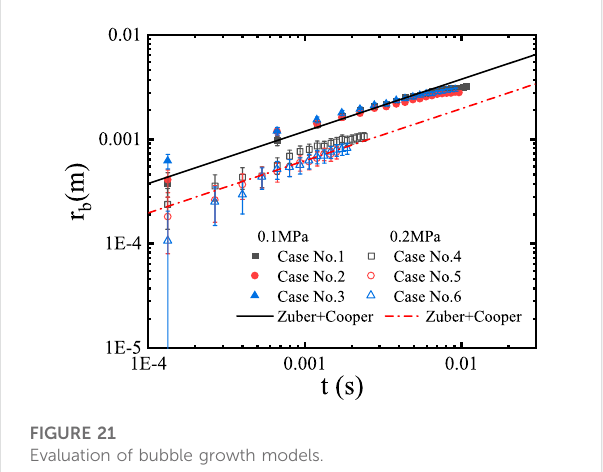
FIGURE 21 Evaluation of bubble growth